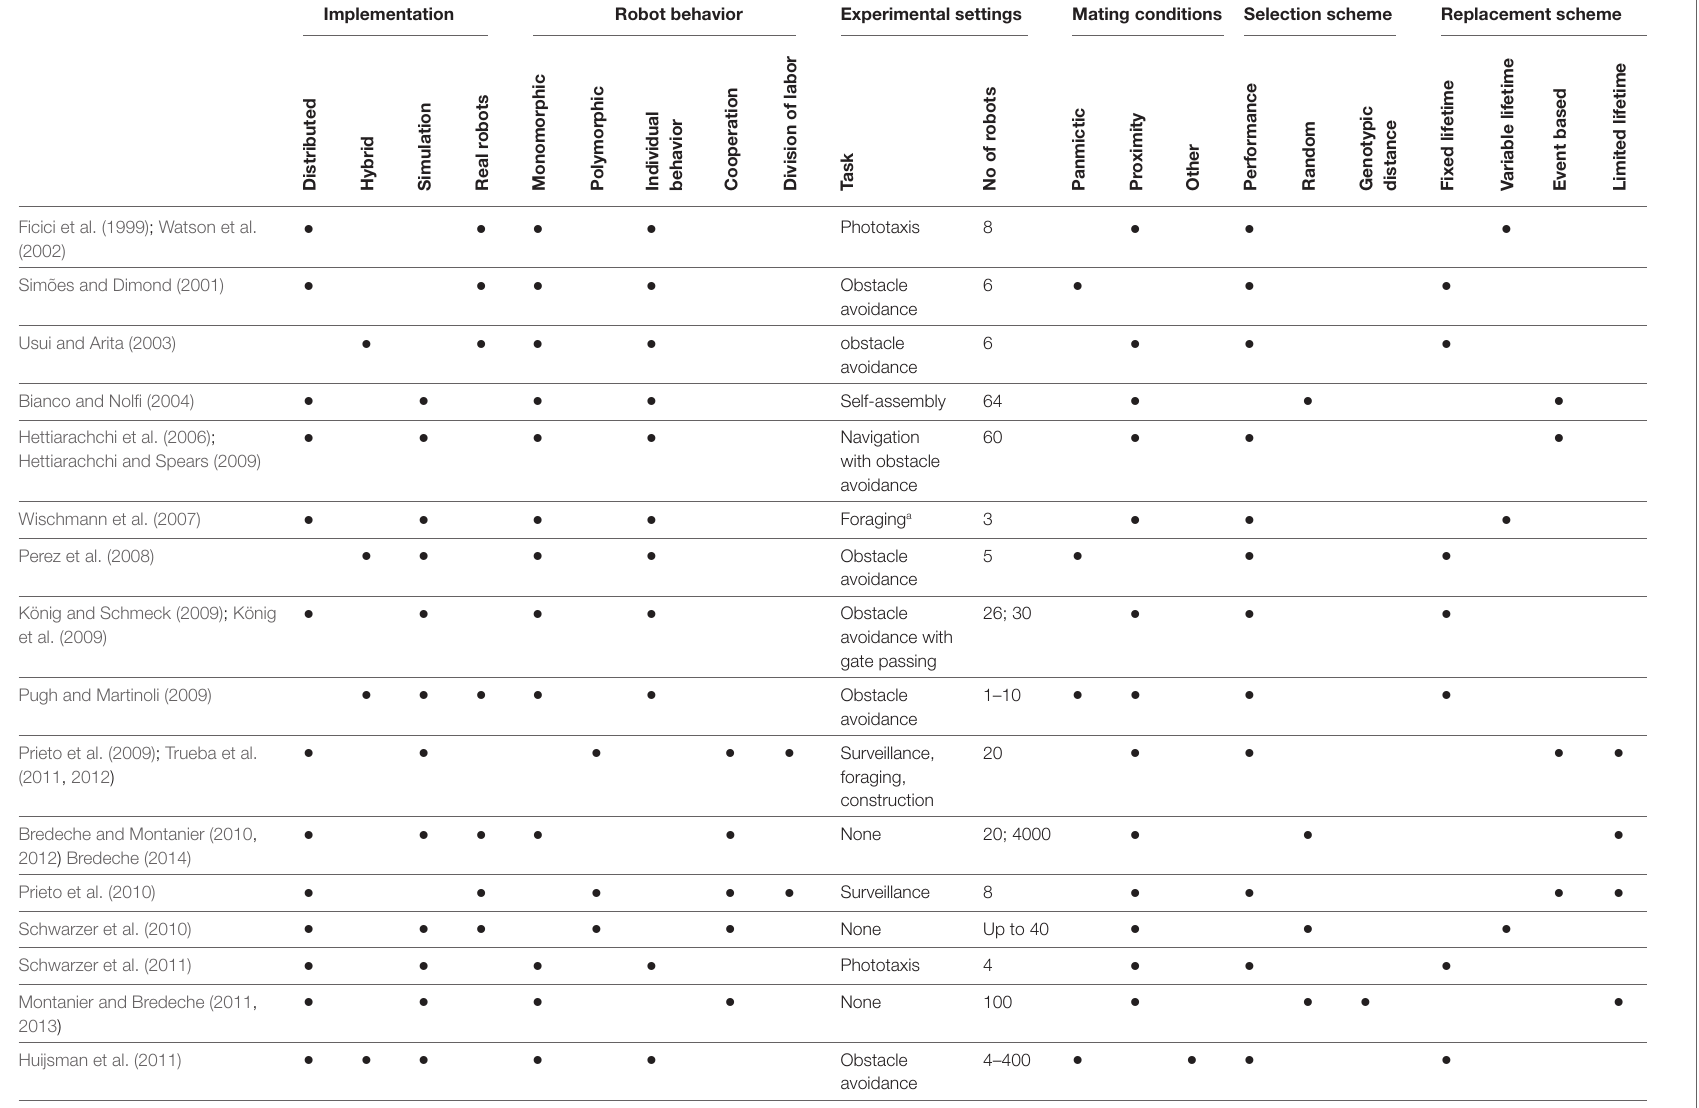
TABLe 1 | Overview of Embodied Evolution